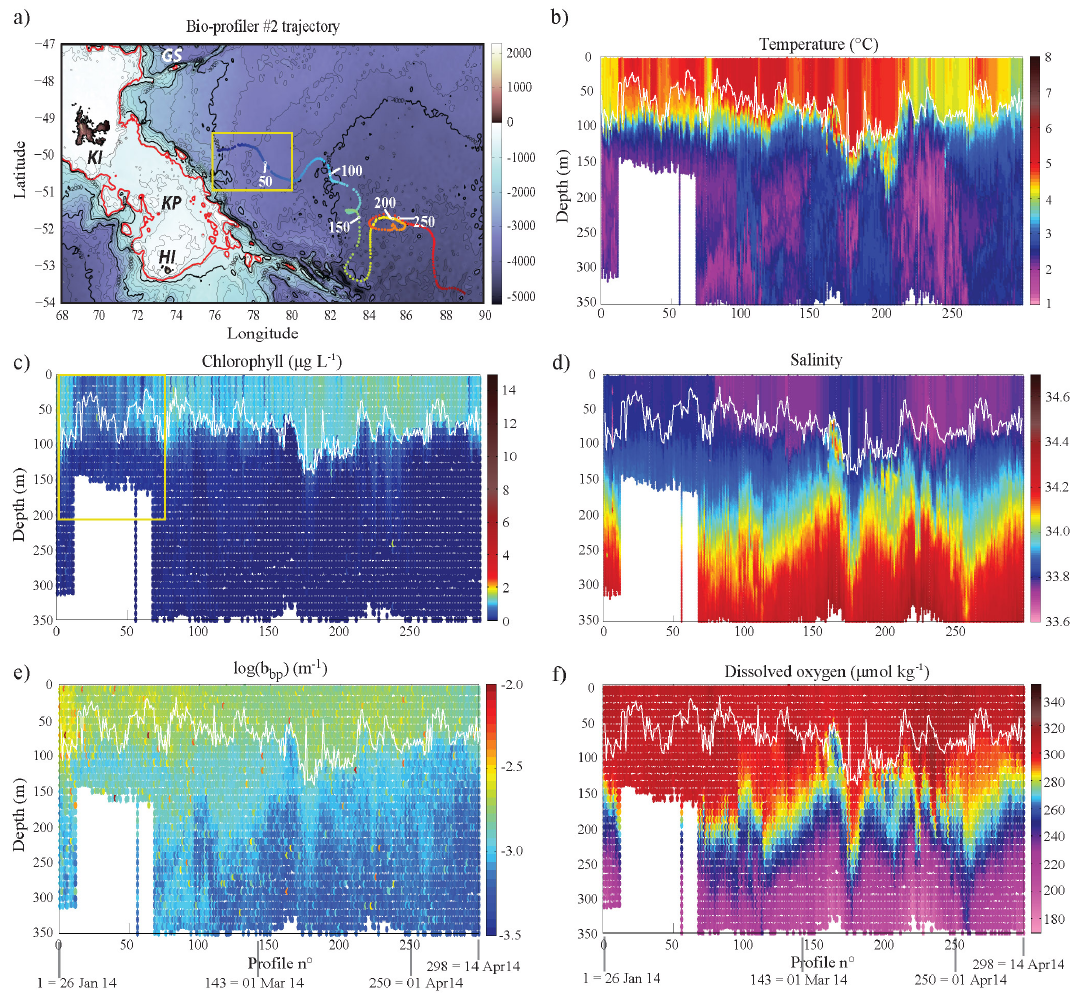
Figure 4. Same as Fig. 3 but for bio-profiler